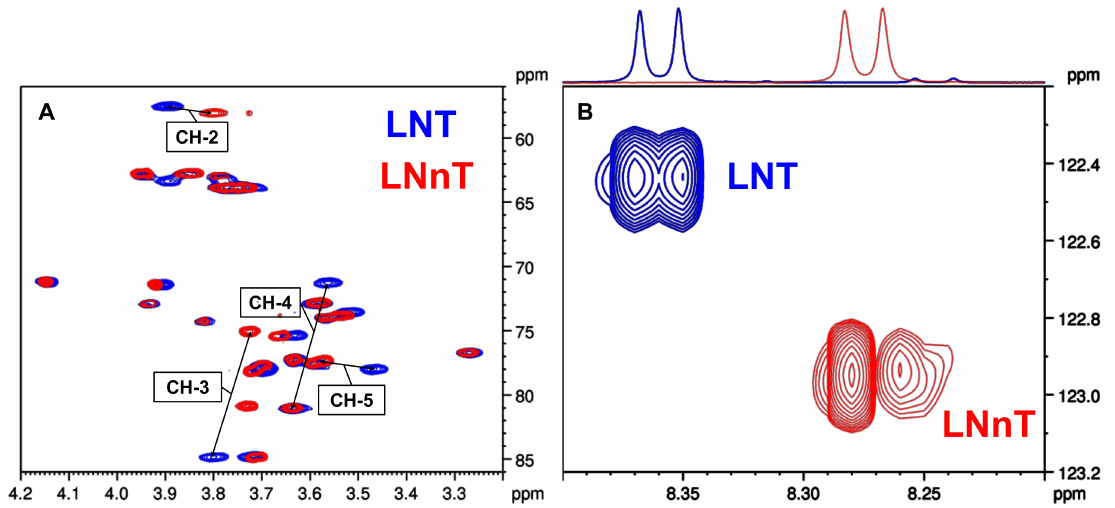
Figure 3. Overlaid 2D NMR spectra of the isomeric LNT and LNnT. ( A ) Overlaid 1 H- 13 C HSQC spectra of LNT and LNnT, indicating 1 H and 13 C NMR chemical shift perturbations of the GlcNAc moiety. ( B ) Overlaid 1 H- 15 N HSQC spectra of LNT and LNnT, indicating the remarkably different 1 H- 15 N correlations of the GlcNAc